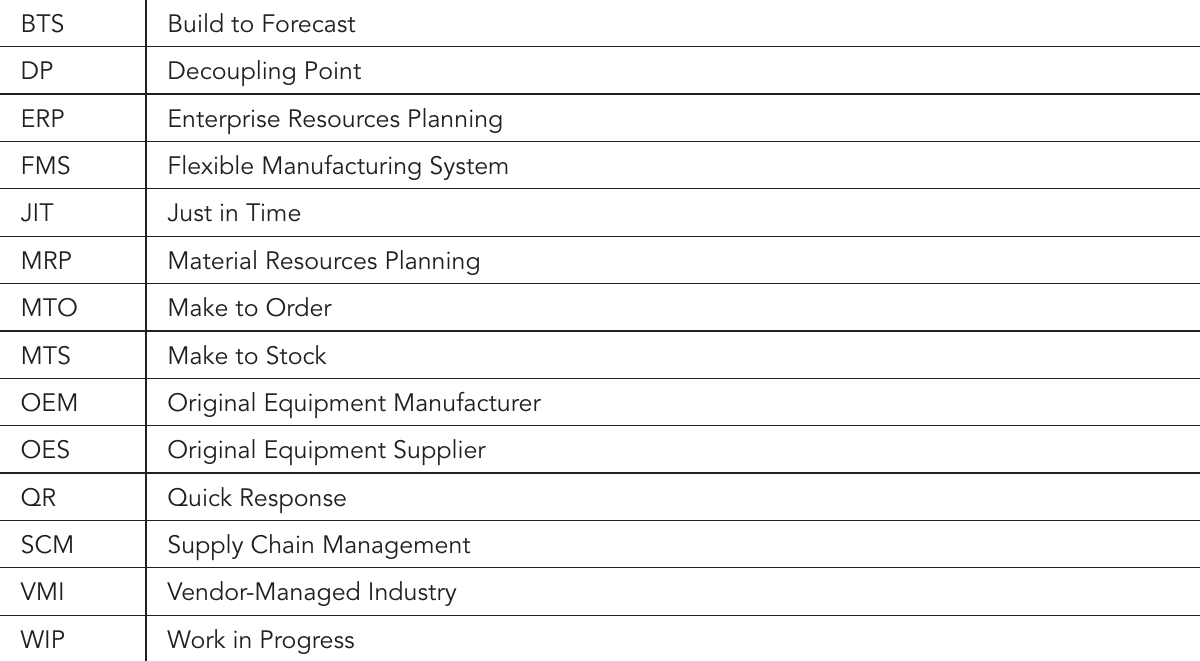
BTS Build to Forecast DP Decoupling Point ERP Enterprise Resources